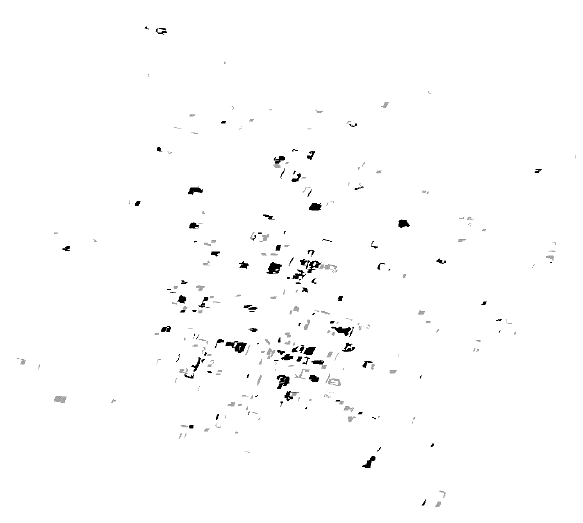
Figure 10 . Reference debris components subdivided into those that were detected (black) and those that were not